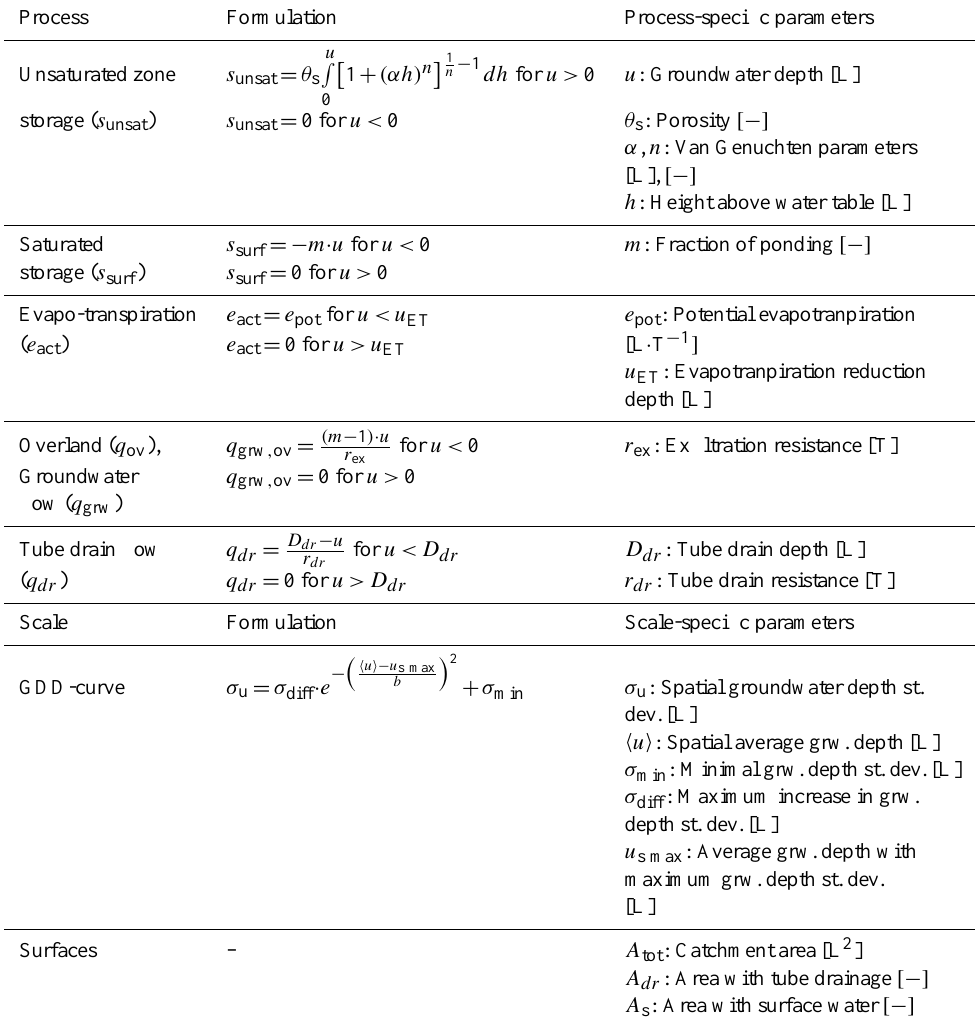
Table 1. LGSI-Model basics and parameters. The process formulations are point-scale model equations. The catchment-scale equations are obtained by integration over the groundwater depth distribution within appropriate integration bounds (see Appendix